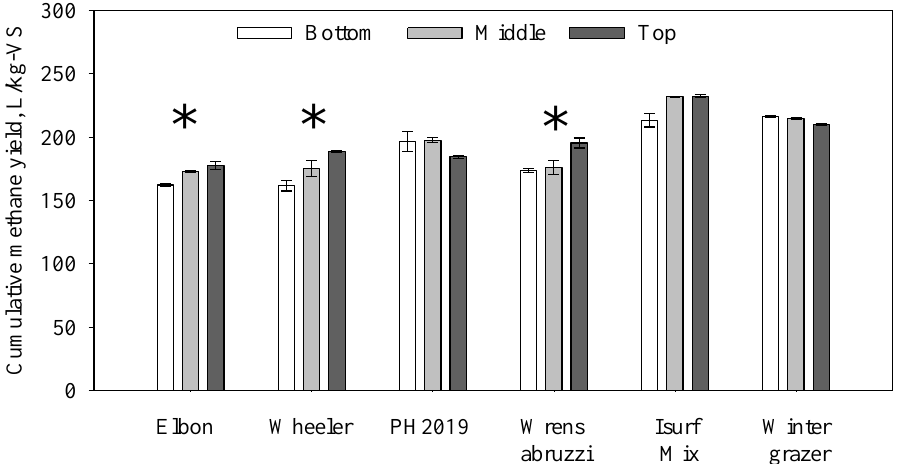
Figure 1. Cumulative methane yields from cereal rye. The asterisk indicates significant differences between the three plant sections.